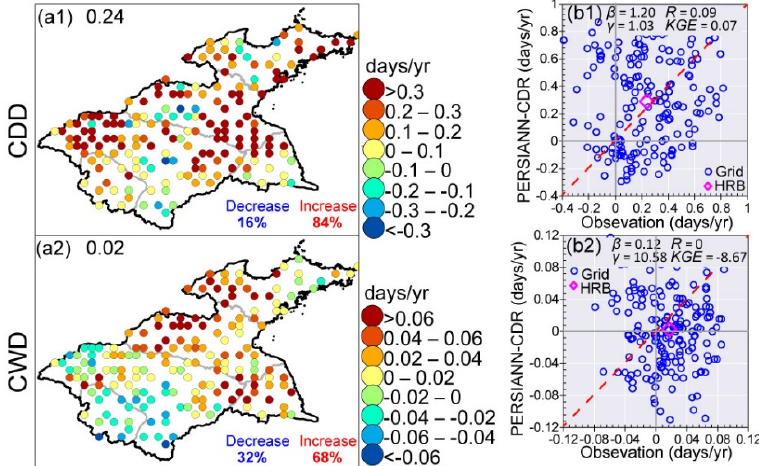
Figure 7. Spatial patterns of the temporal trends of the observational duration-based indices and the scatterplots between observation and PERSIANN-CDR. a1 , a2 ( b1 , b2 ) are for CDD and CWD, respectively. In a1 , a2 , the black numbers represent the HRB trends of the observational duration- based indices, while the blue (red) numbers indicate grid percentages with increasing (decreasing) trend across the HRB. The red dashed line in b1 , b2 is the 1:1